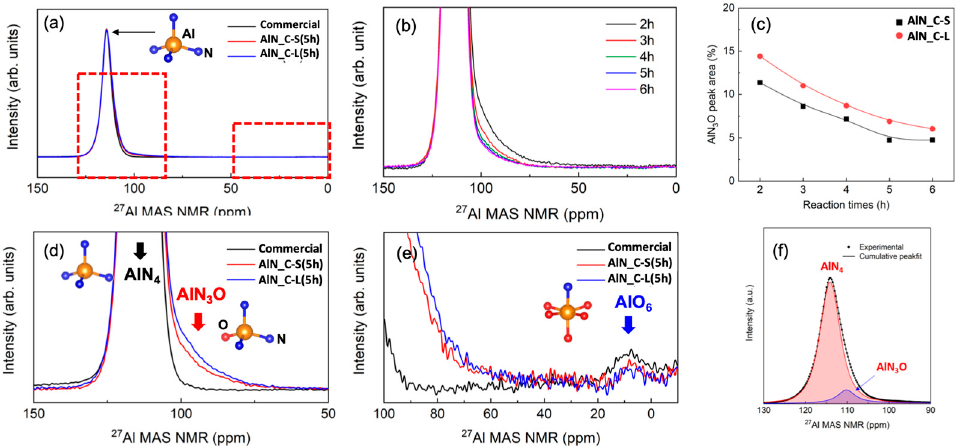
Figure 3. ( a ) 27 Al solid-state NMR spectra for raw materials (AlN_C-S/C-L) showing shoulder peaks (~110 ppm) due to AlN 4 O defects. Very weak peaks due to AlO 6 defects are found for AlN_C-S/C-L and commercial material (see Figure 3e for enlarged image). ( b ) The evolution of shoulder peak at ~110 ppm for AlN_C-S as a function of carbothermal reaction time. The intensity of the peaks decreases as oxygen concentration decreases with increasing carbothermal reaction time. ( c ) Fitted peak areas due to AlN 3 O defects of the main peak in Al NMR spectra are shown. ( d ) Comparison of AlN 3 O peaks of AlN_C-S/C-L (5 h) with commercial materials. ( e ) Comparison of AlO 6 peaks of AlN_C-S/C-L (5 h) with commercial materials. ( f ) Fitting of experimental spectra with AlN 3 O and AlN 4 profiles.